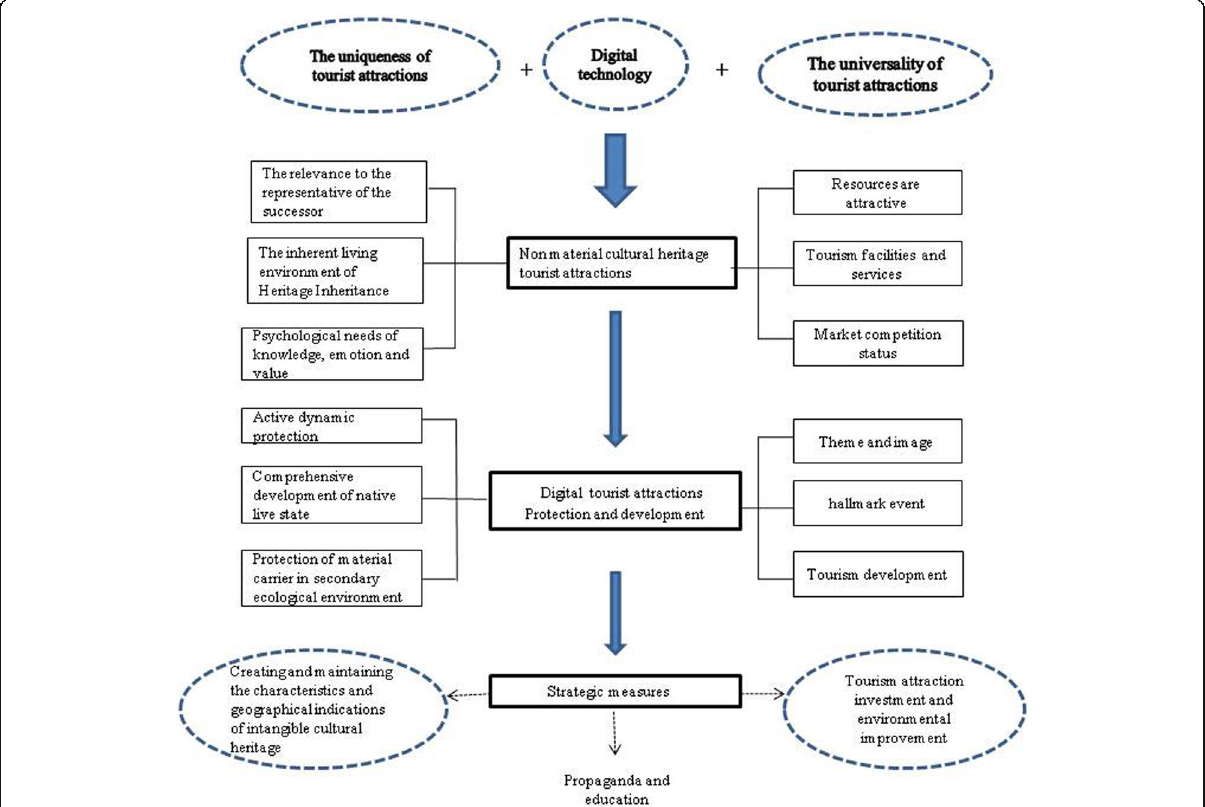
Fig. 1 Construction of digital tourist attractions of